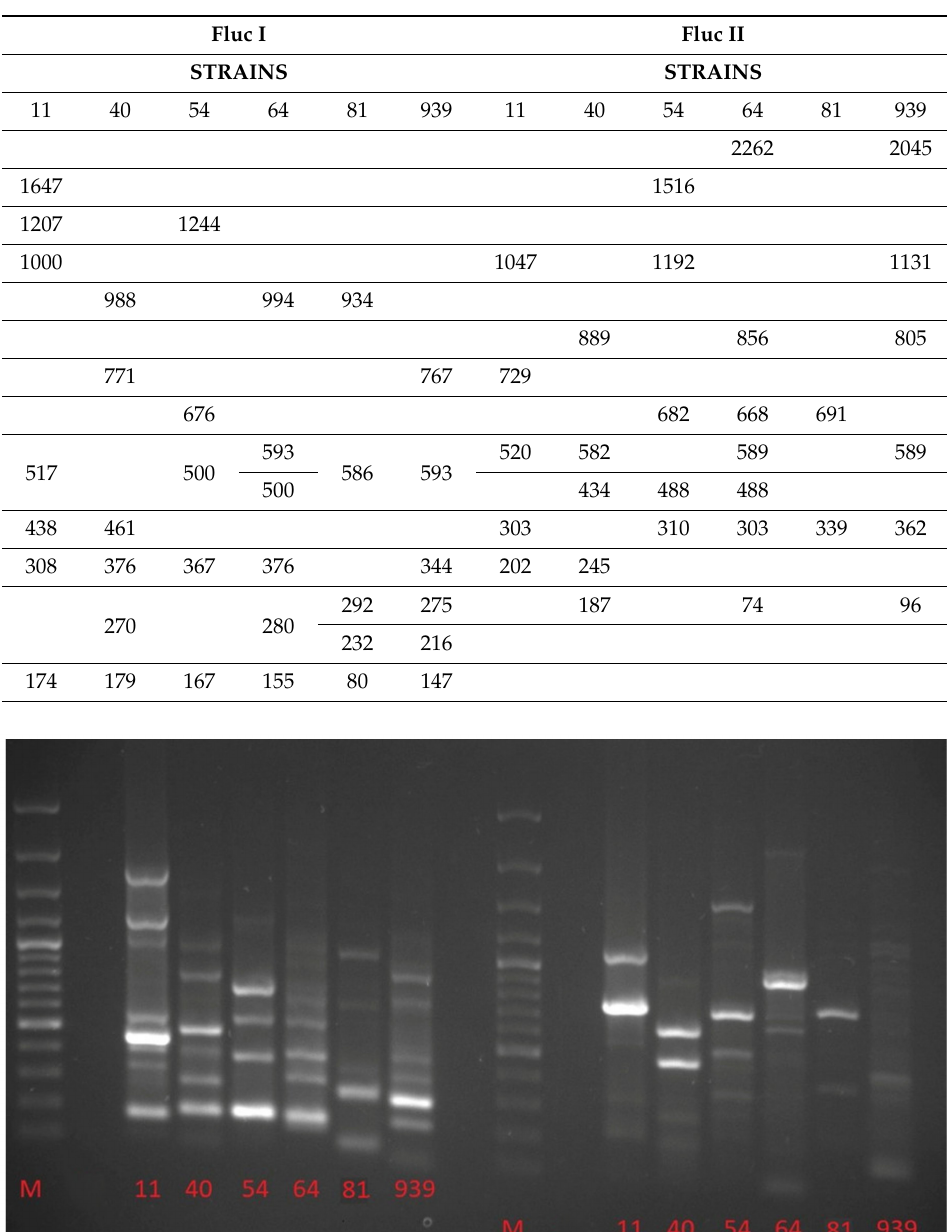
Table 2. Base pair length of amplification products using fluc I and fluc II primers.